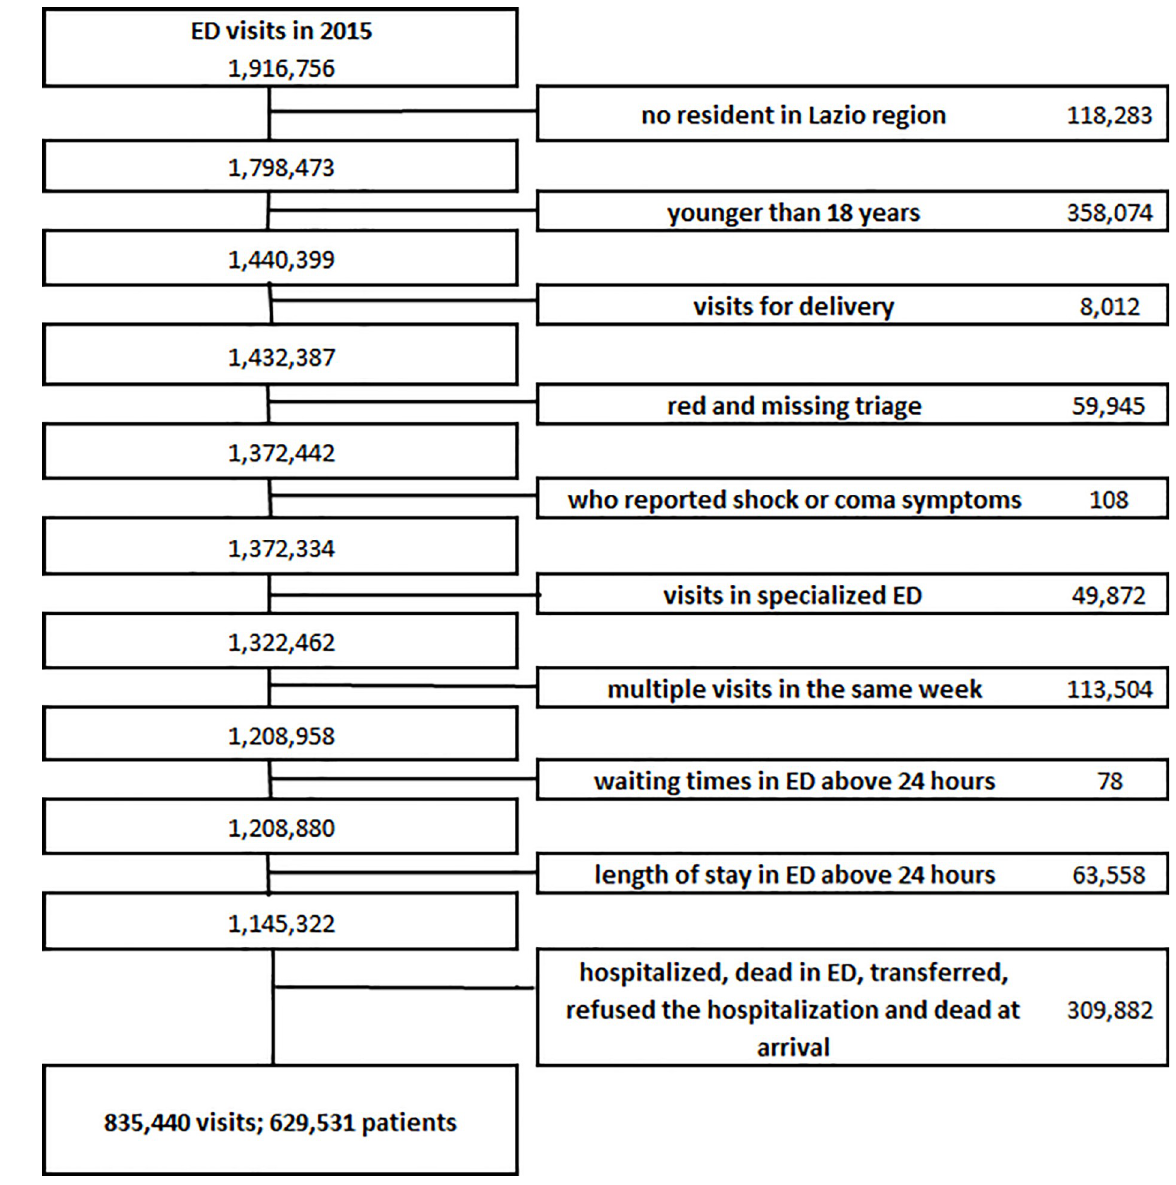
Fig 1. Summary of the cohort enrolment—exclusion criteria. cause a post-acute status (OR = 0.94) and for patients with foreign citizenship (OR = 0.94). The risk of LWBS is higher for non-assisted arrival (OR = 1.22), for patients who arrived dur- ing the afternoon and the night (OR = 1.46 and OR = 1.16), during week-end or holidays (OR = 1.12) and in a crowded ED (OR = 1.30). This risk increases with decreasing urgency of the triage category (OR = 2.05 for green triage, OR = 7.01 for white triage, compared to yellow ones) and with increasing wait times (OR = 32.31 > 6 hours compared to those who wait < 1 hour). The risk of LWBS is lower for resident in the province of Rome compared to those liv- ing in the rest of the region (OR = 0.90). The tendency to leave ED is higher for patients who have already done it once (OR = 1.45) or more than once in the previous year (OR = 3.26).